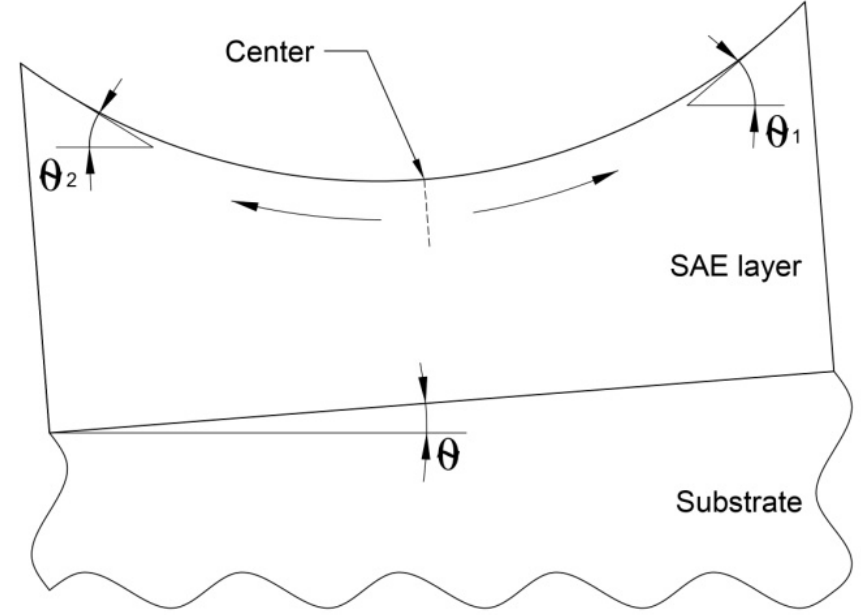
Nanomaterials 2021 , 11 , x FOR PEER REVIEW Figure 5. Schematic view of a SAE layer on a misoriented substrate. Figure 5. Schematic view of a SAE layer on a misoriented substrate.